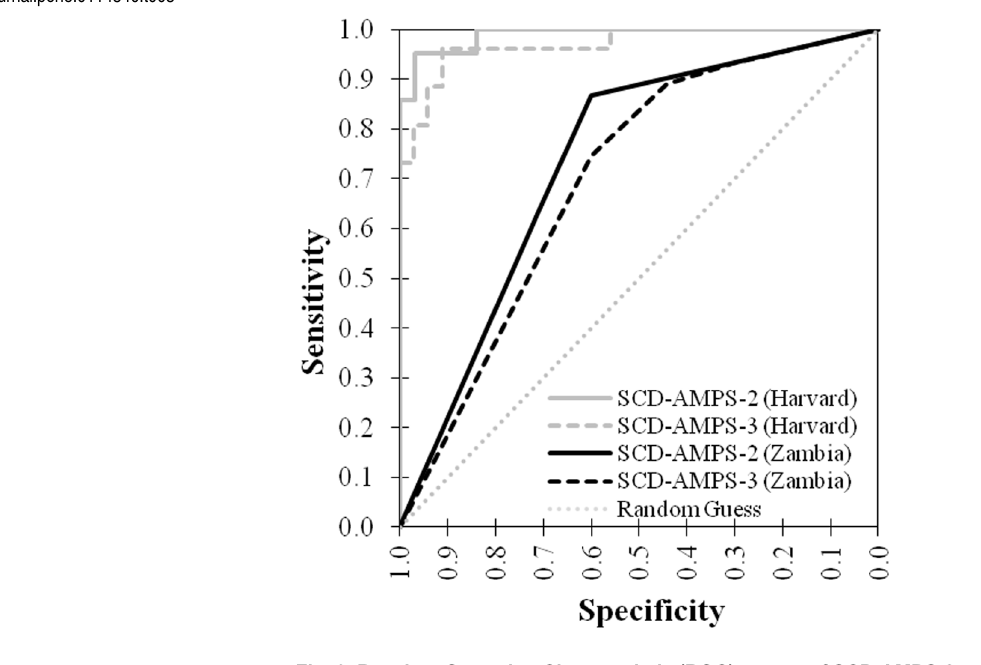
Fig. 3. Receiver Operating Characteristic (ROC) curves of SCD-AMPS-2 and SCD-AMPS-3 including all data from Zambia shows fair discriminative ability. The amount of red cells below the bottom phase of each test was evaluated by eye and classified on a five point scale. Both tests showed an ability to discriminate sickle cell disease from non-disease. In general, the specificity was lower than the sensitivity of the